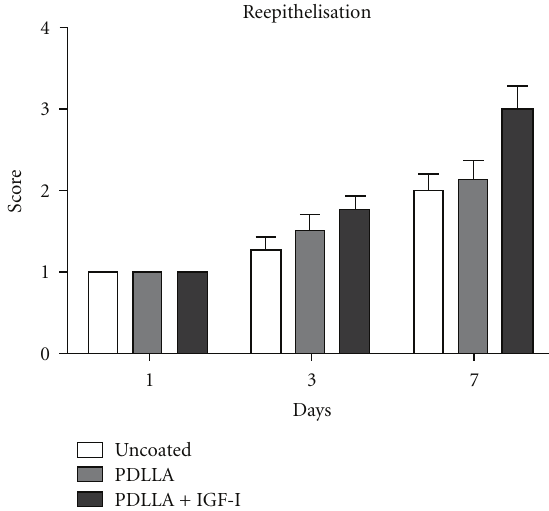
Figure 6: Reepithelisation of the mucosa became obvious especially at day seven after surgery in all groups, and a tendency of ad- vanced reepithelisation was seen at this time point in the IGF-I- treated group. In this group the increase of reepithelisation became significant already in between days one and three and three and seven, whereas a significant di ff erence in the control groups not until day seven after surgery occurred.